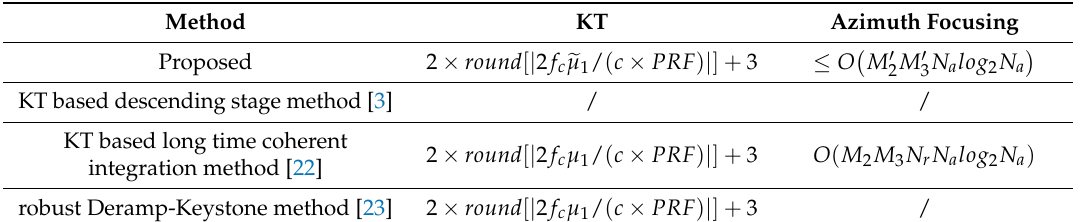
Table 2. Computational burden comparison.